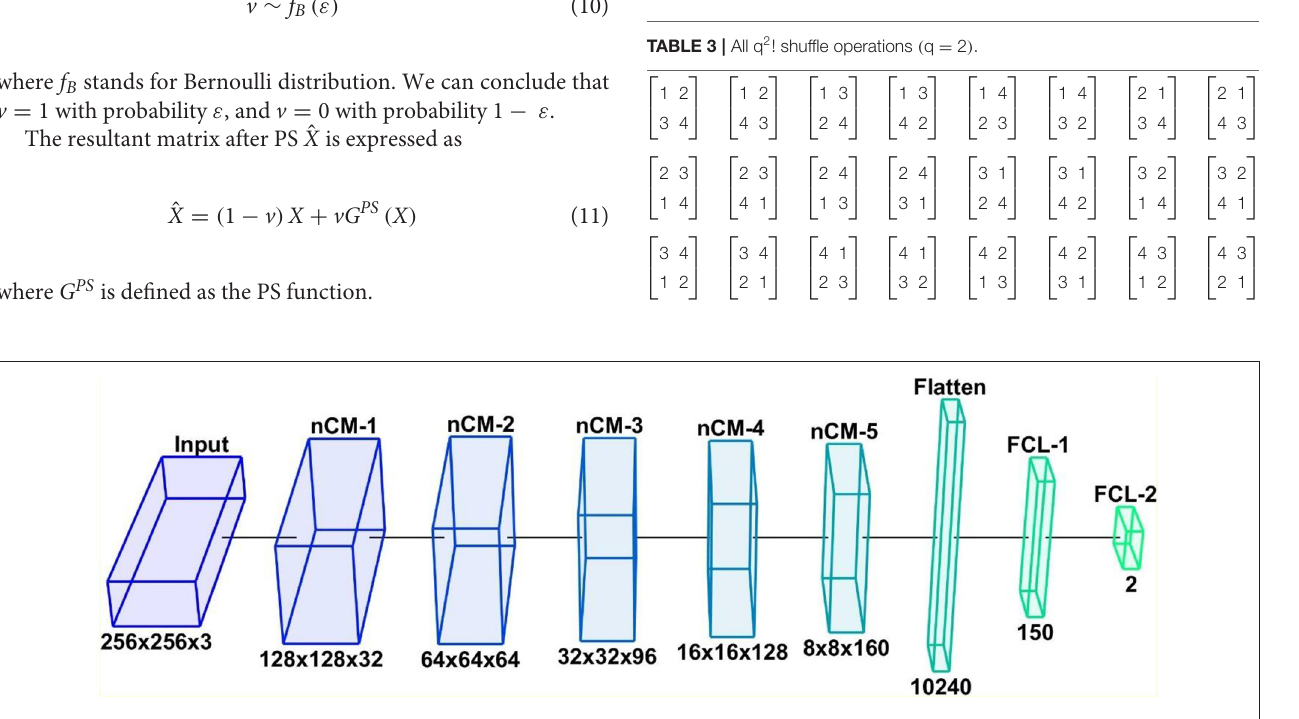
FIGURE 6 | Diagram of sizes of feature maps (SFMs) in our backbone network.